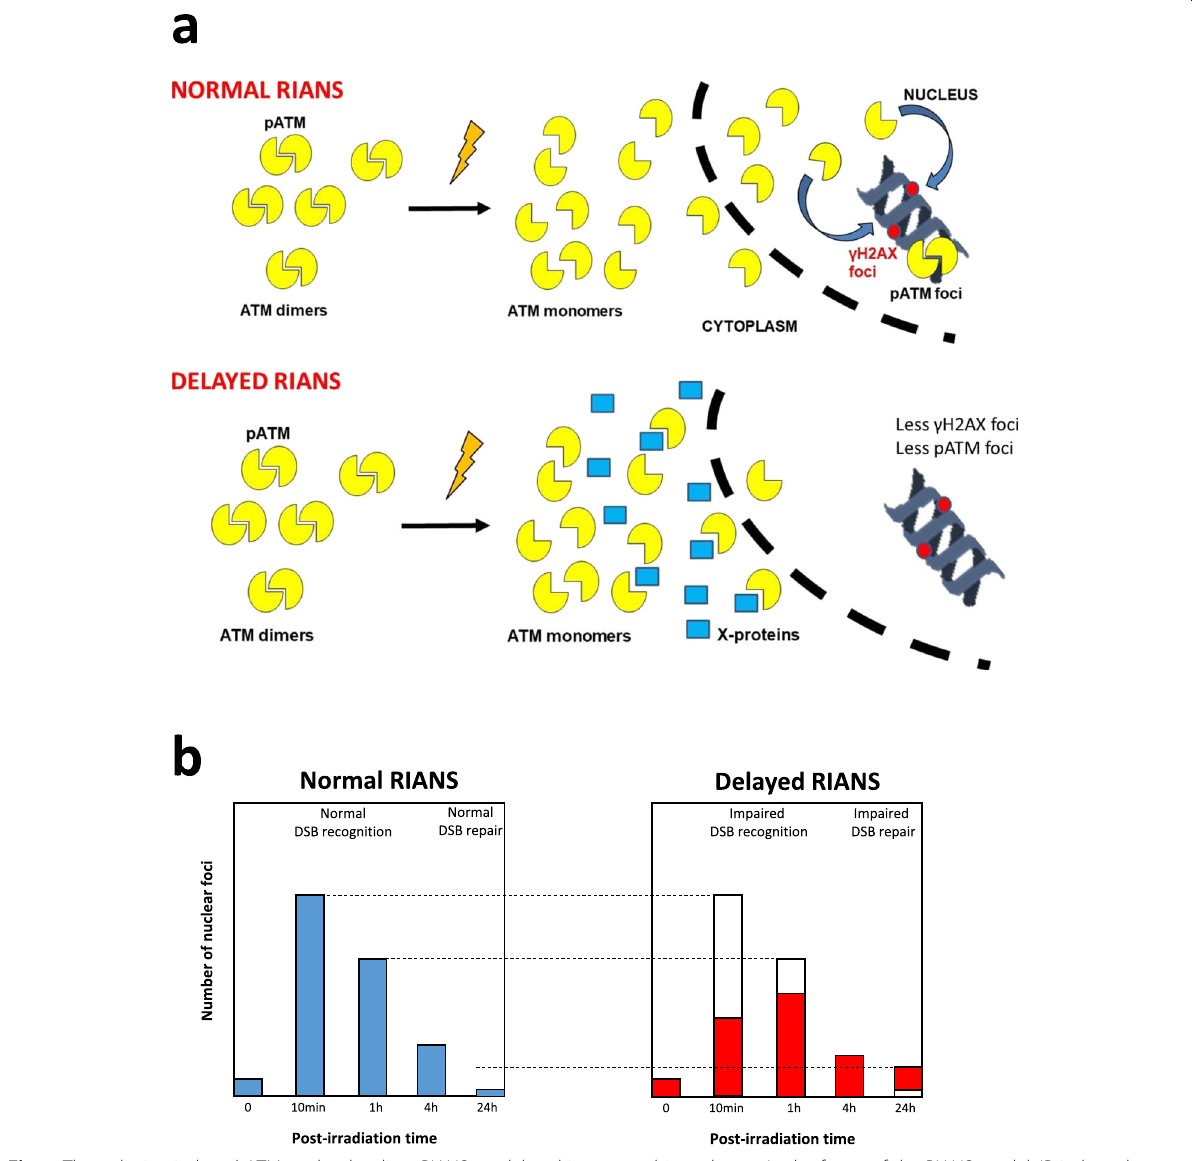
Fig. 1 The radiation-induced ATM nucleoshuttling: RIANS model and its current biomarkers. a In the frame of the RIANS model, IR induce the monomerisation of the ATM dimers in cytoplasm. The resulting ATM monomers diffuse in the nucleus and phosphorylate the H2AX histone variant molecular ( γ H2AX) at DSB sites, which triggers the formation of nuclear γ H2AX foci, easily quantifiable by immunofluorescence. This is the recognition step. The recognised DSB are repaired by the non-homologous end-joining, the major DSB repair pathway in humans (see refs. [8, 16 – 21]). During the DSB repair process, two ATM monomers reassociate on the DSB sites and form the nuclear autophophorylated ATM (pATM) foci, also visible by immunofluorescence. b In the kinetics of γ H2AX or pATM foci appearance, the early (10 min, 1 h) post-irradiation times provide information on the functionality of the DSB recognition step while the late (24 h) ones provide information on the functionality of the DSB repair step. ATM Ataxia telangiectasia mutated gene/protein, DSB Deoxyribonucleic acid double-strand breaks, RIANS Radiation-induced nucleoshuttling of the ATM protein, γ H2AX Phosphorylated forms of the H2AX histone variant